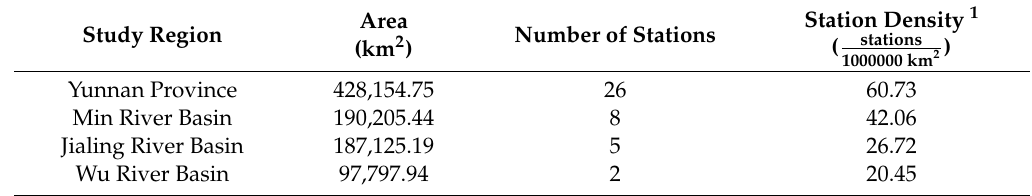
Table 1. Areas, numbers of stations, and station densities of the four study regions in Southwest